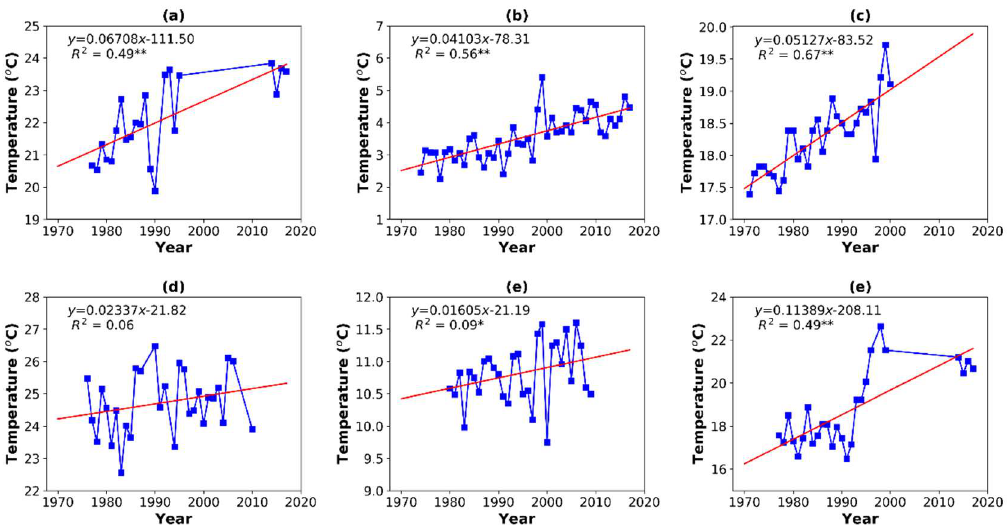
Figure 12. Temporal trend of the annual mean near-surface air temperature observed at six selected meteorological stations: ( a ) Surkhet, ( b ) Tingri, ( c ) Kathmandu, ( d ) Bagdogra, ( e ) Chame, and ( f ) Dhankuta. (* Significant at a 90% confidence level; ** Significant at a 95% confidence level).